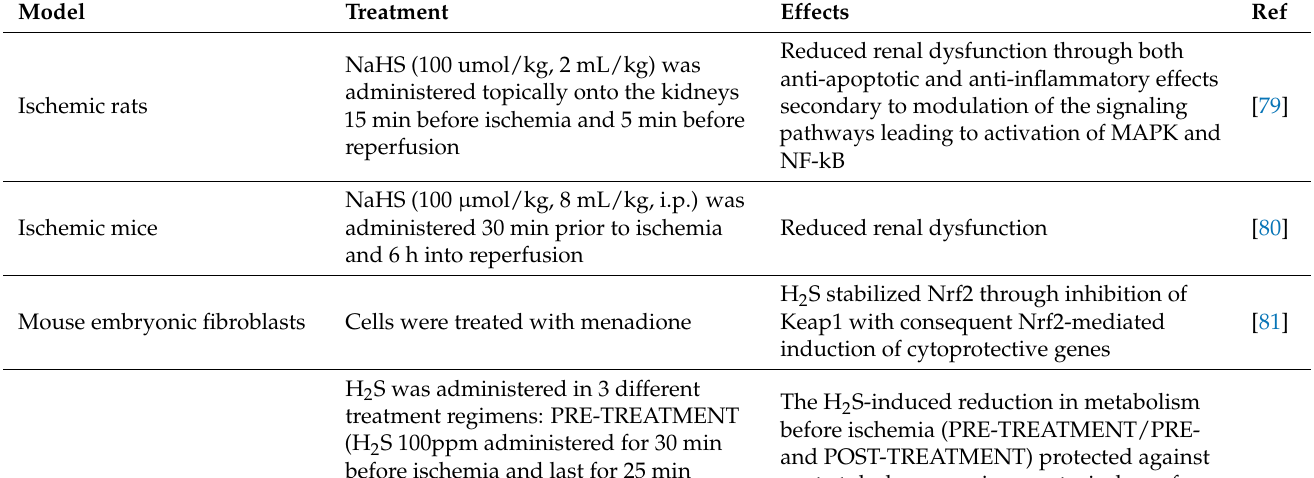
Table 2. Studies reporting the beneficial effects of H 2 S in animal models of I/R